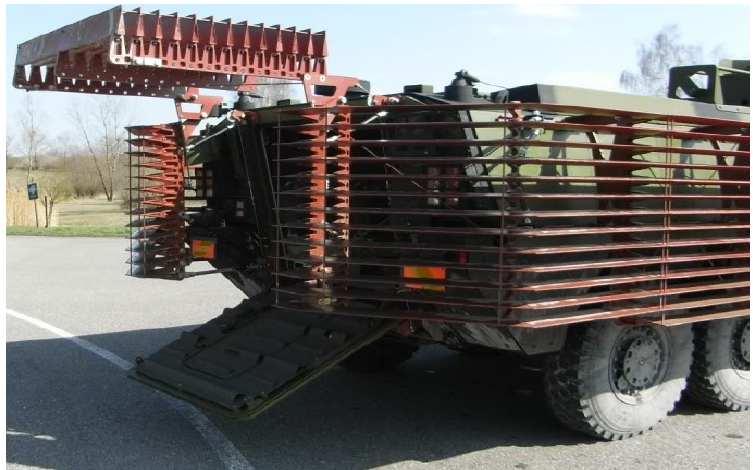
Figure 16. Example of a V-shaped slat armour system on a Danish Piranha vehicle.